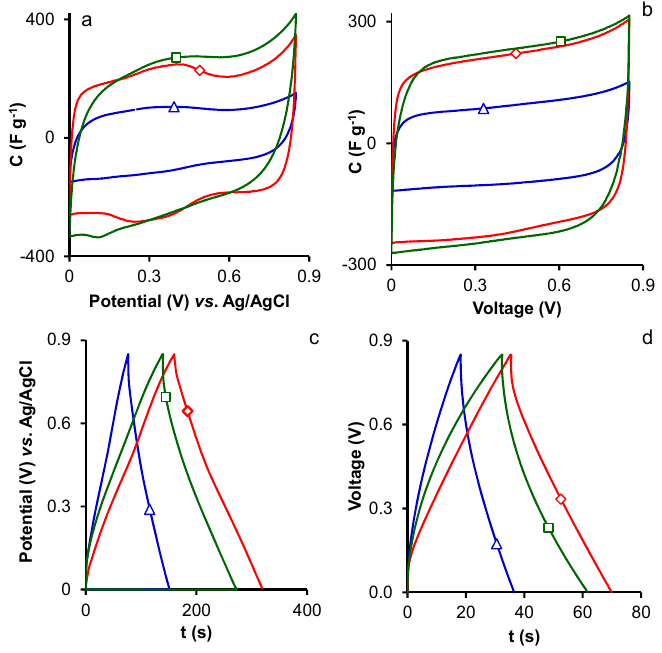
Figure 2. CVs at 2.5 mV·s − 1 of samples: ( a , b ) MA1 ( △ ), MA2 ( □ ), and MA3 ( ◇ ); and ( c , d ) GCDs at 1 A·g − 1 of samples MA1 ( △ ), MA2 ( □ ), and MA3 ( ◇ ).